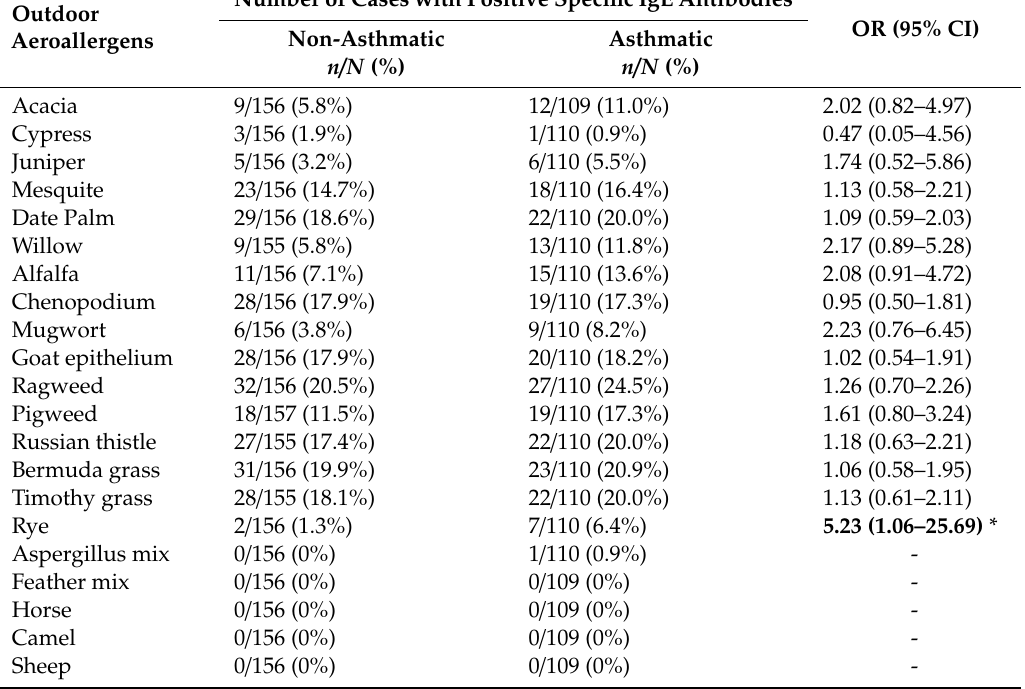
Table 3. Distribution of positive IgE antibodies specific to outdoor aeroallergens among the study sample of adult